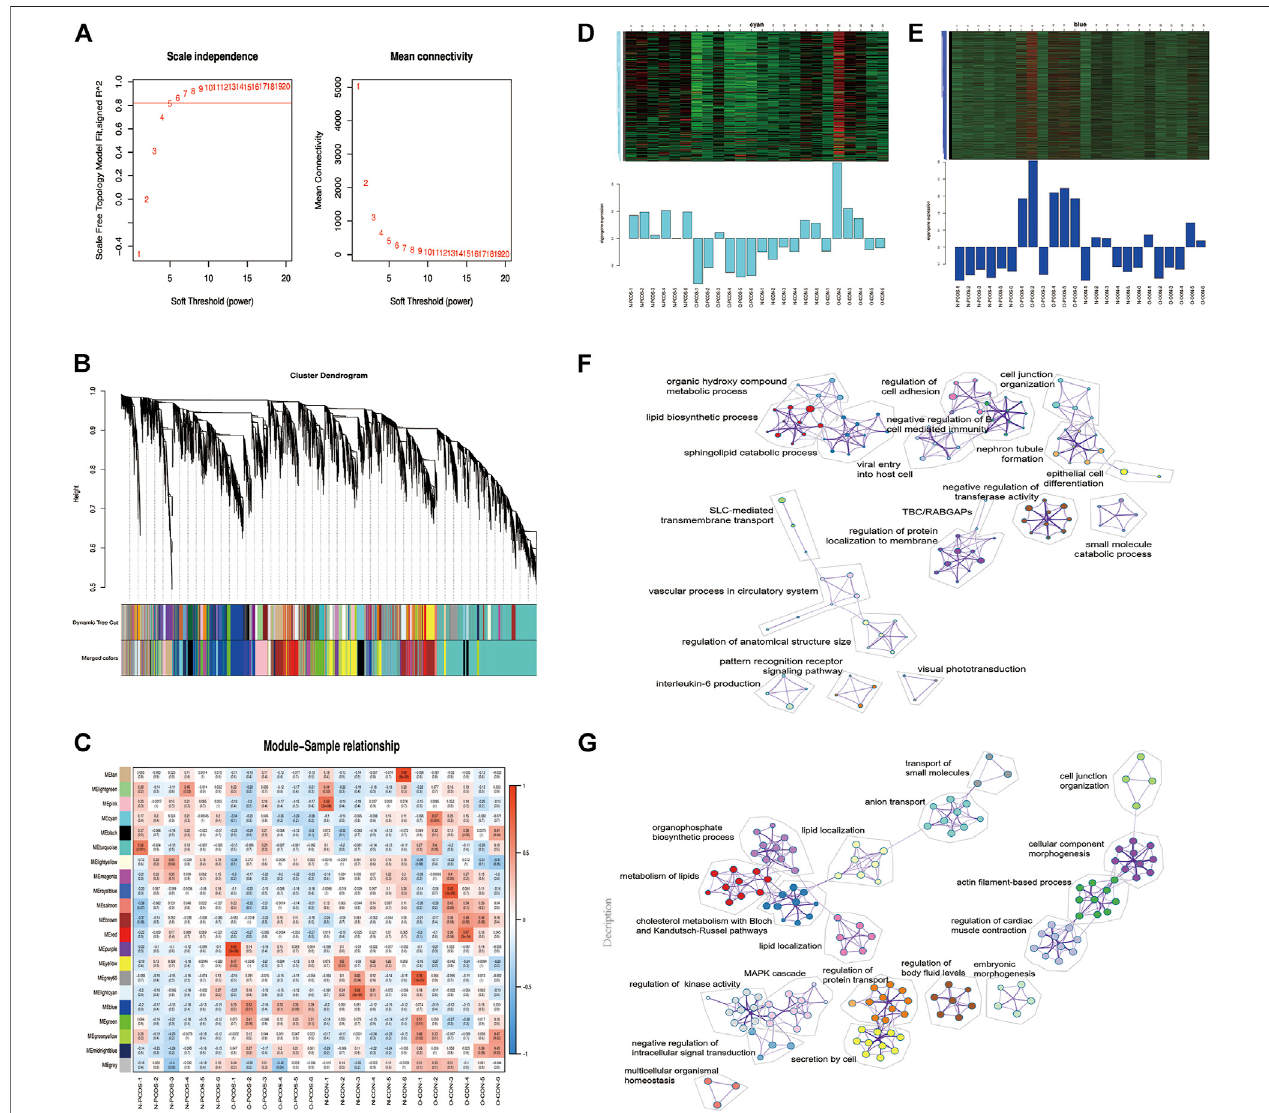
FIGURE 3 | Weighted co-expression network construction and identi fi cation of key modules. (A) Determination of soft threshold power. (B) Dendrogram of all DEGs clustered based on the measurement of dissimilarity. The color band shows the results obtained from the automatic single block analysis. (C) Heatmap of the correlation between the module eigengenes and endometrium samples of PCOS and controls. (D,E) Heatmap ofthe modular dynamic gene expression patterns. (F,G) Network of enriched GO terms of genes containing in the cyan and blue modules, colored by GO cluster ID.